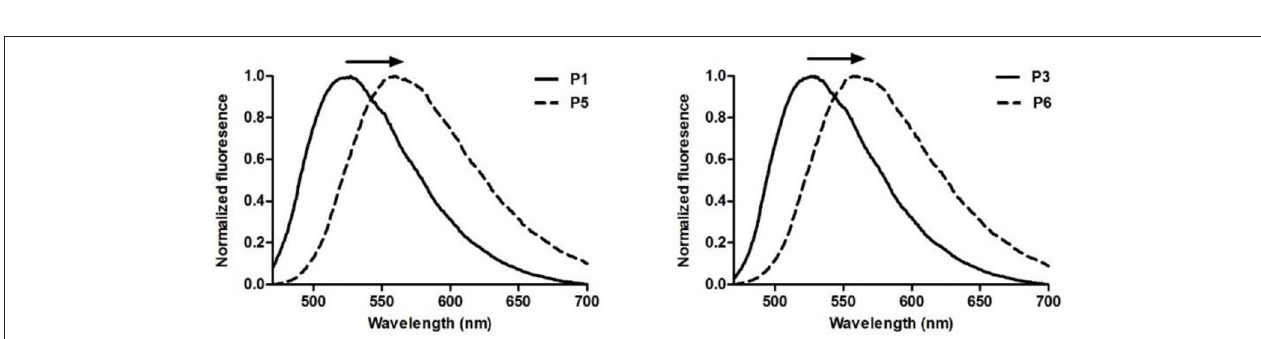
FIGURE 2 | Comparison of normalized emission spectra of phenazine probes without ( P1 , P3 ) and with ( P5 , P6 ) alkyne substitution. Spectra were recorded at 50 µ M. λ exc. :